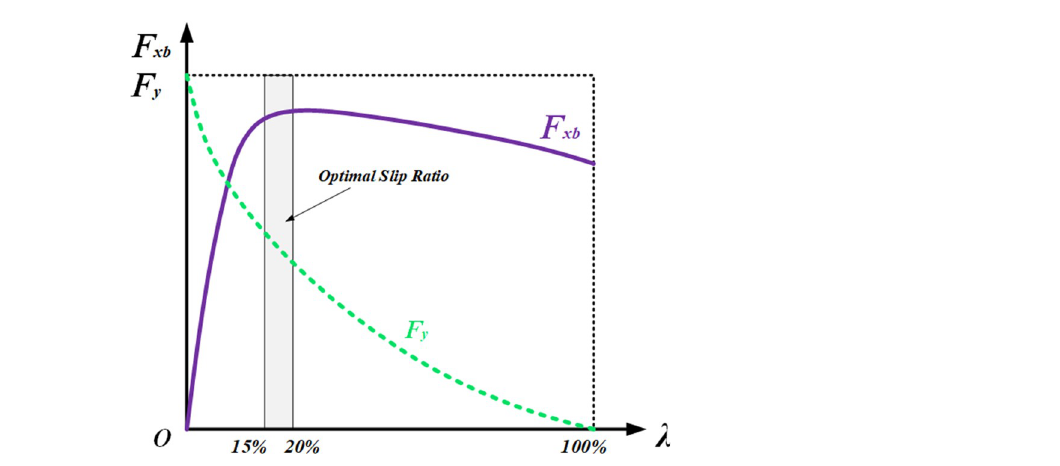
Fig 5. The relationships between the F xb and the F y with the λ